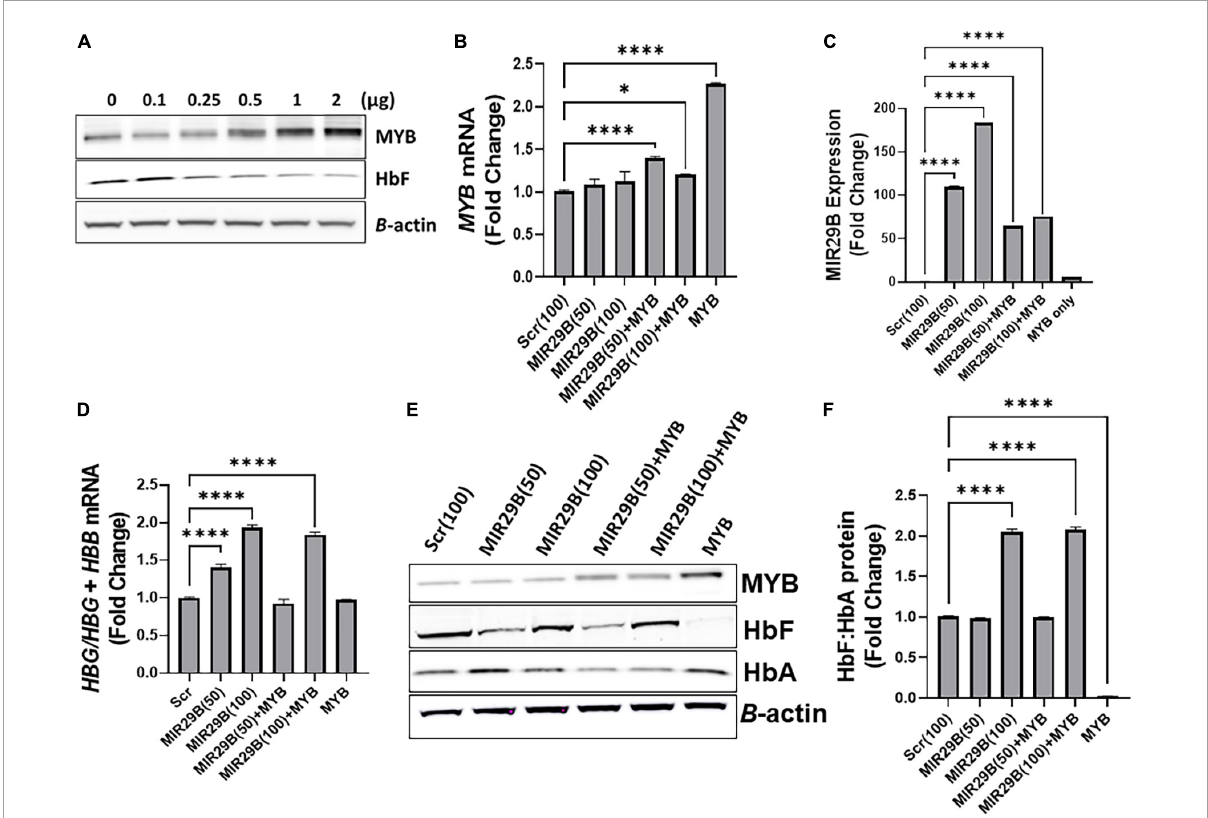
FIGURE2 MicroRNA29B (MIR29B) mediates HBG reactivation via inhibiting MYB in KU812 cells. (A) Western blot analysis of MYB and HbF protein expression relative to β -actin protein in KU812 cells transfected with increasing concentrations of MYB plasmid DNA ( µ g). Fold change of (B) MYB mRNA relative to β -actin, (C) MIR29B expression relative to RNU48, and (D) HBG -to- HBB mRNA ratio as a function of HBG / HBG + HBB mRNA expression in KU812 cells following transfection for 48 h with MIR29B mimic (50 or 100 nm) alone or in combination with MYB overexpression plasmid vector (2 µ g). (E) Western blot of MYB, HbF, and HbA protein expression with β -actin internal control. (F) Bar graphs showing quantification of the ratio of HbF-to-HbA protein in KU812 cells transfected with MIR29B alone or in combination with MYB. * P < 0.05 ** P < 0.005, *** P < 0.0005, and **** P < 0.0001 is statistically